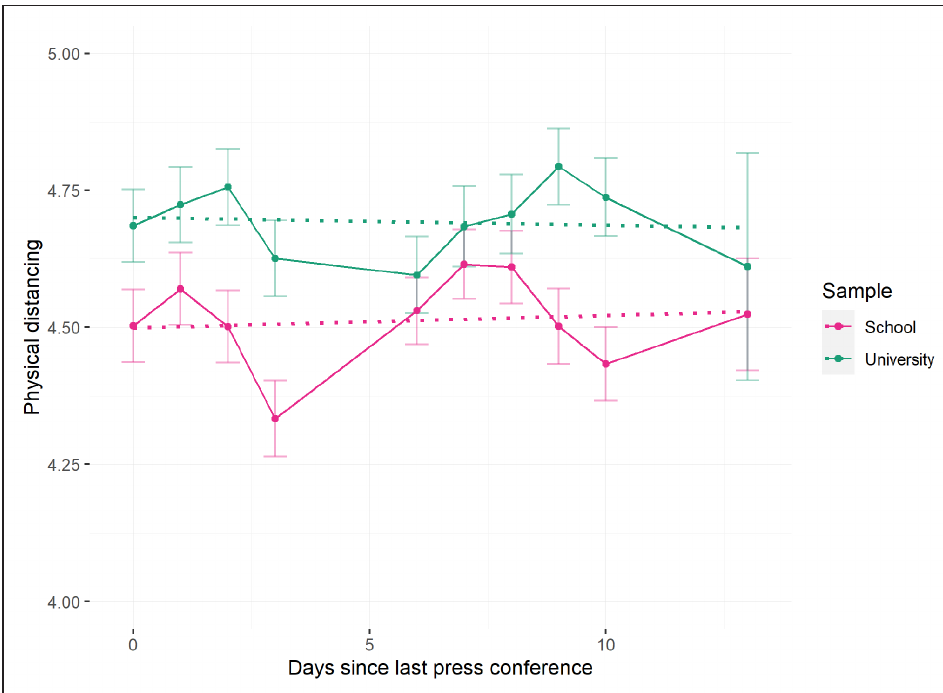
Figure 3 Average Physical Distancing Behavior in the Two Samples in the Days After a National Press Conference. Note : The dotted line represents the estimated linear relation between the mean physical distancing behavior and the days since the last press